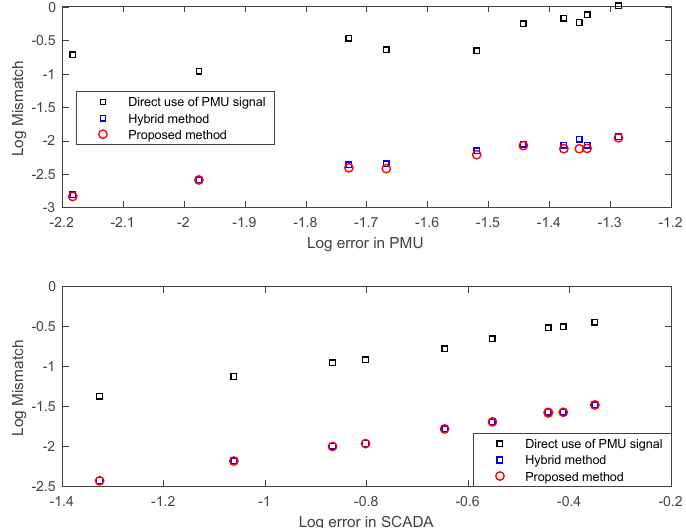
Figure 6. Performances of the state estimators with various measurement errors; (top) errors from PMU (phasor measurement unit) measurements, and (bottom) errors from SCADA (supervisory control and data acquisition) measurements.